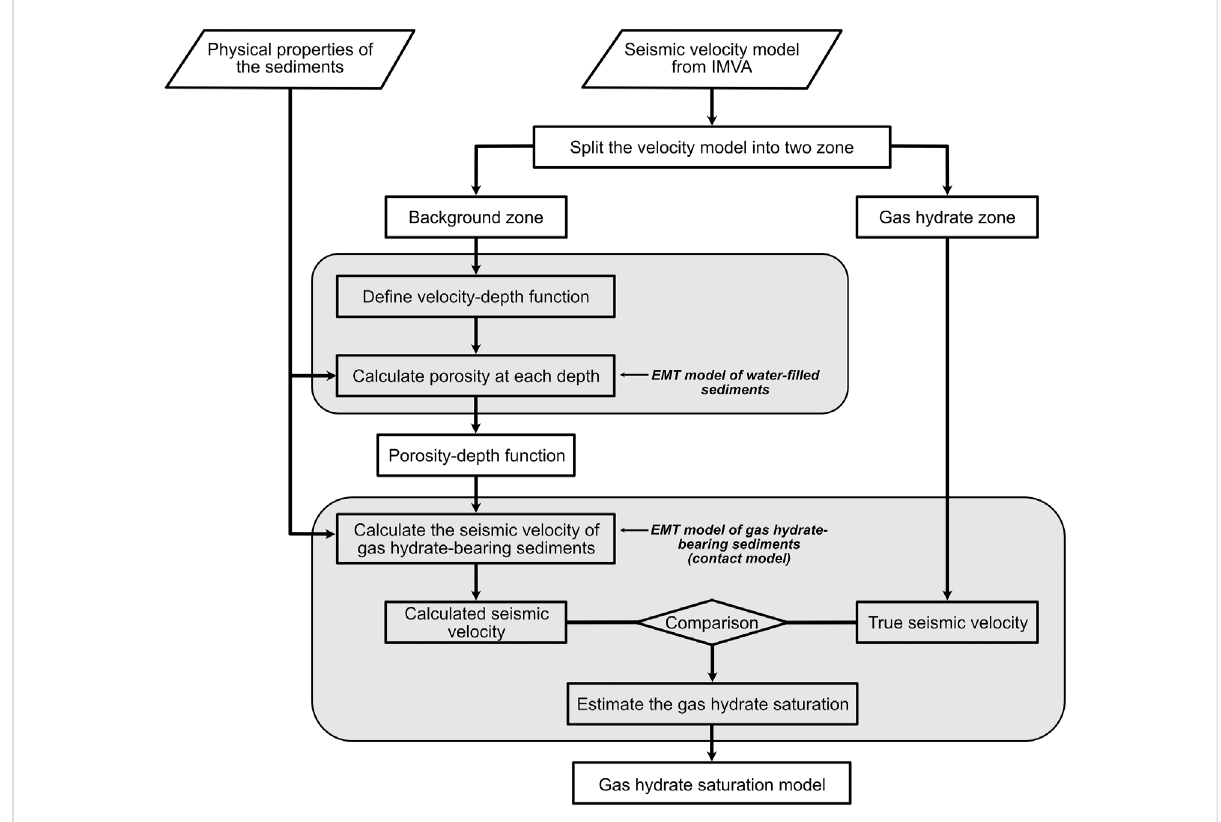
FIGURE 5 Detailed work fl ow to estimate the gas hydrate saturation model using the EMT model.